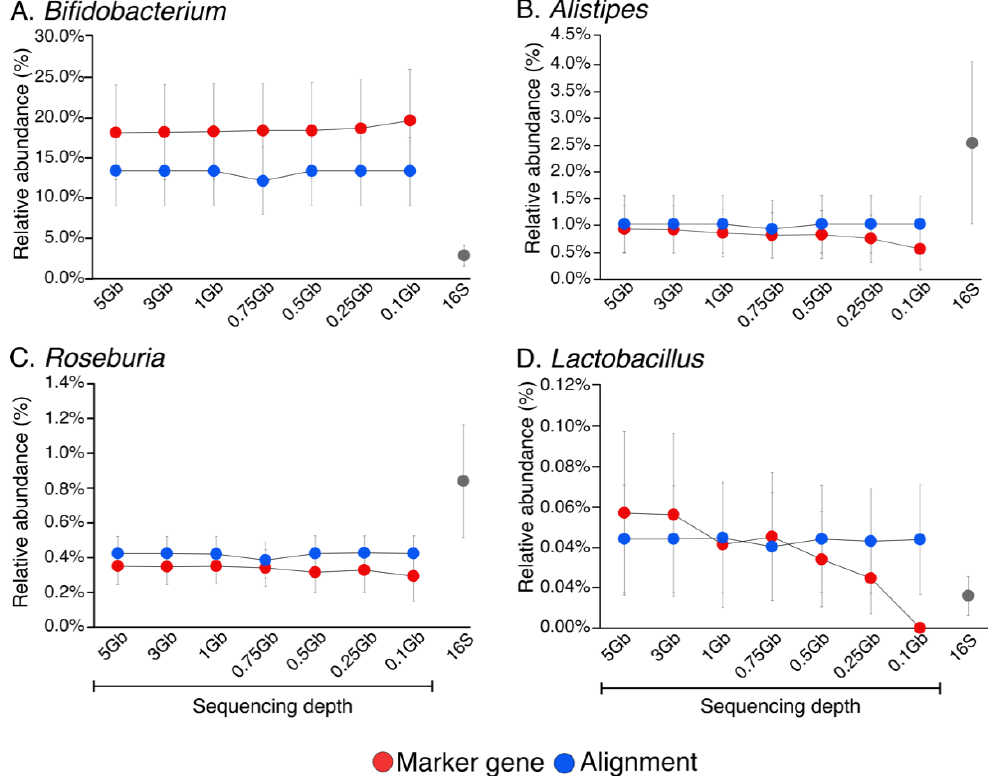
Figure 3. Line charts of the average relative abundances (%) (genus level) of selected stool taxa based upon SMS data annotated using marker gene-mapping- and alignment-based methods. Data were annotated at various sequencing depths including 5 Gb (16.67 M reads), 3 Gb (10.00 M reads), 1 Gb (3.00 M reads), 0.75 Gb (2.50 M reads), 0.5 Gb (1.65 M reads), 0.25 Gb (0.85 M reads), and 0.1 Gb (0.35 M reads). The 16S sequencing data were included for comparison. ( A ) Bifidobacterium SMS data annotated using marker gene-mapping- and alignment-based methods. ( B ) Alistipes SMS data annotated using marker gene-mapping- and alignment-based methods. ( C ) Roseburia SMS data annotated using marker gene-mapping- and alignment-based methods. ( D ) Lactobacillus SMS data annotated using marker gene-mapping- and alignment-based methods. Standard error is shown by error bars.